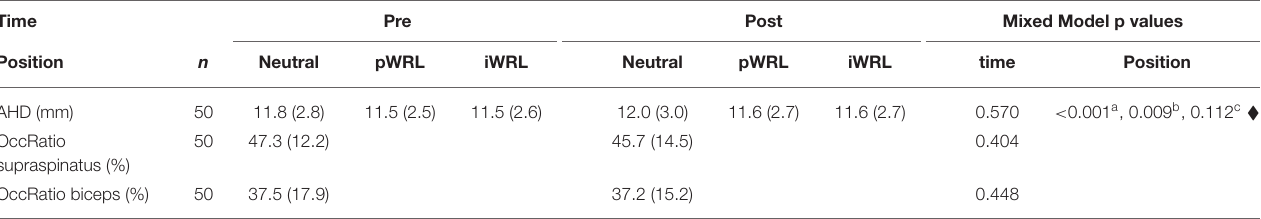
TABLE 2 | Unadjusted values [mean (SD)] of the dependent variables acromio-humeral distance (AHD) and occupation ratio (OccRatio) of supraspinatus and biceps tendon pre- and post-fatiguing wheelchair propulsion and during different positions: neutral, personal weight relief (pWRL) and instructed weight relief (iWRL). Time Pre Post Mixed Model p values